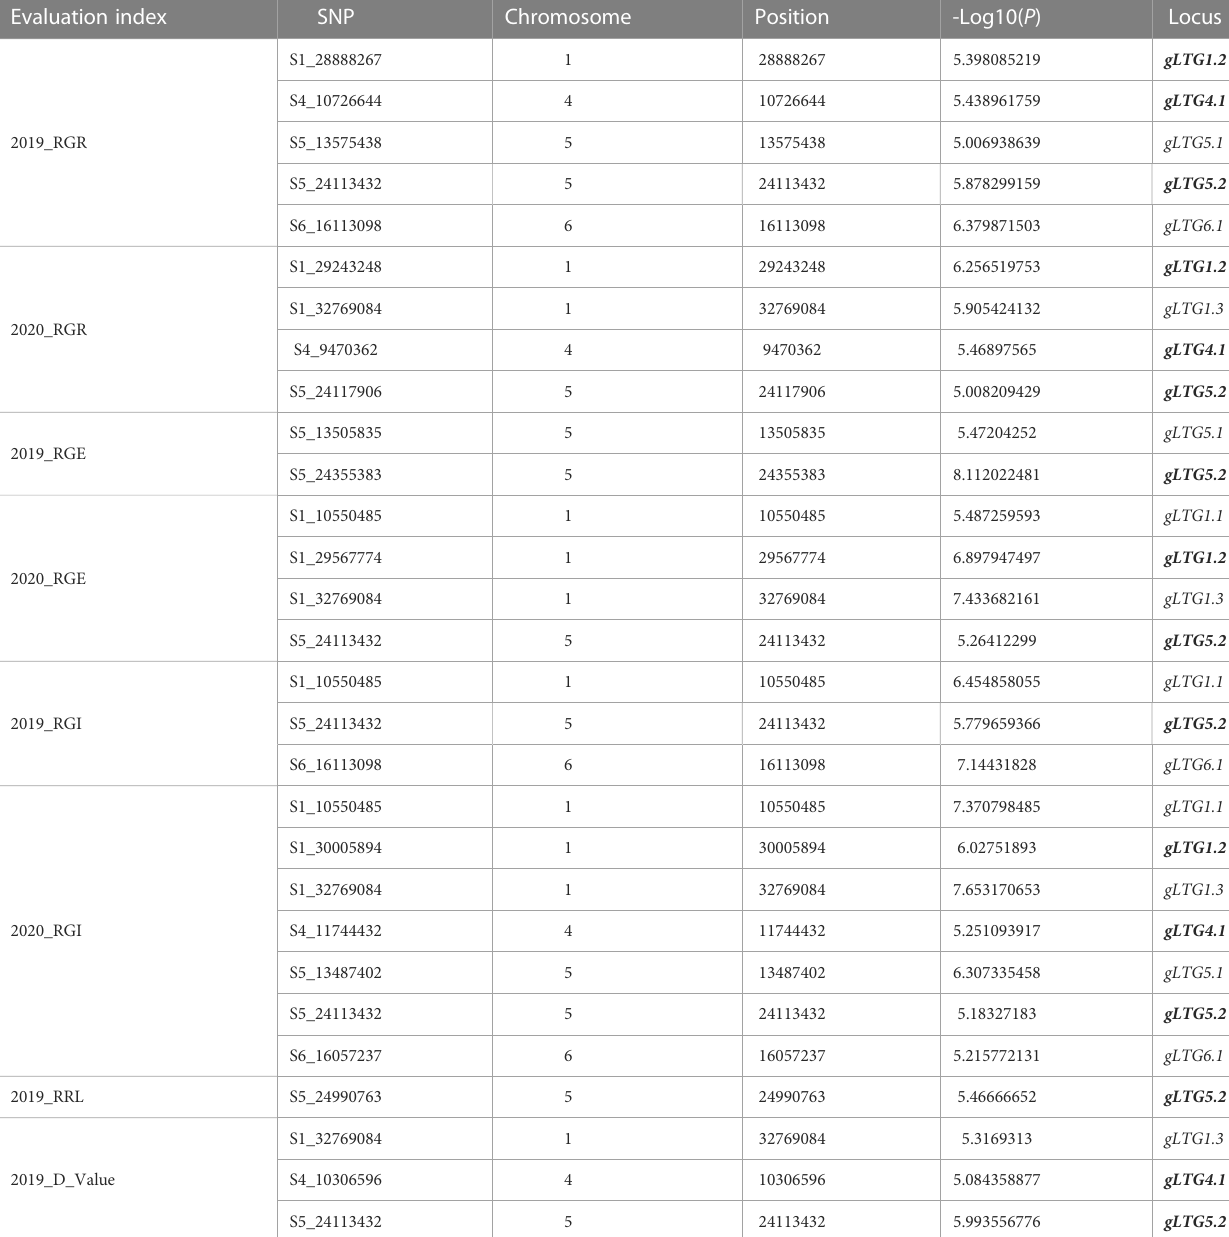
TABLE 2 The highly signi fi cant SNPs by GWAS in gLTG1.1 , gLTG1.2 , gLTG1.3 , gLTG4.1 , gLTG5.1 , gLTG5.2 and gLTG6.1 in two